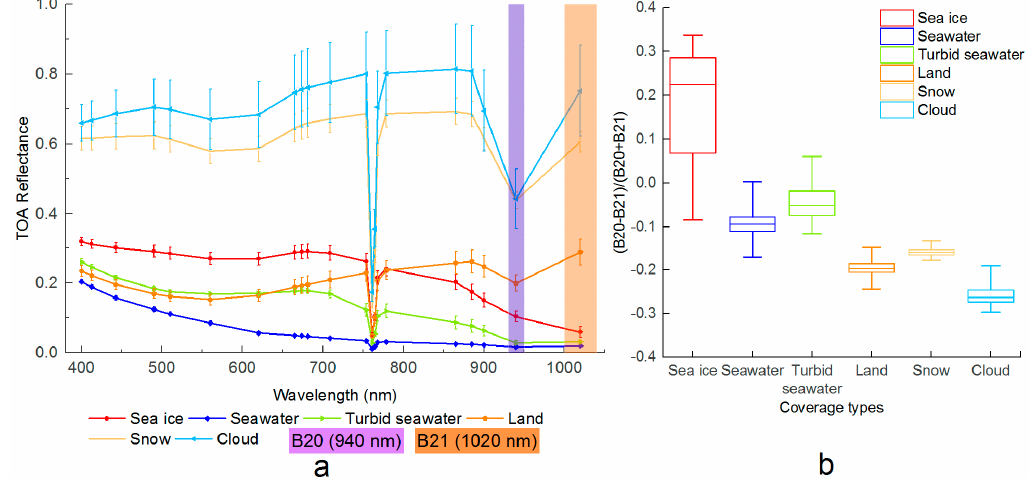
Figure 2. TOA reflectance values in OLCI all bands ( a ) and NDSIII OLCI values ( b ) for sea ice, seawater, turbid seawater, land, snow, and cloud cover in the Bohai Sea. The whiskers in ( a ) depict the standard deviations of the TOA reflectance samples. The whiskers in ( b ) indicate the maximum and minimum ratio values of the sample. The box is determined by the 25th and 75th percentiles of the ratio values of the sample. The median value is marked as the line within the